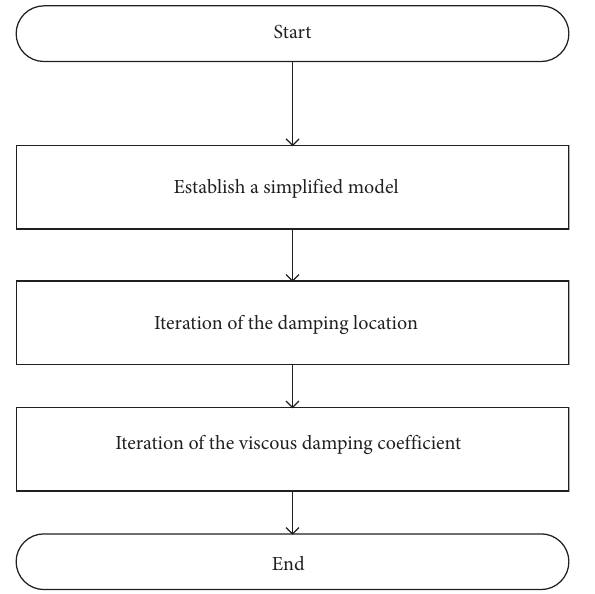
Figure 16: Flowchart of the optimal design of the damped out- rigger system